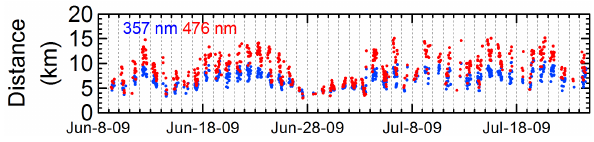
Fig. 17. Horizontal distances ( D ) of air masses measured by MAX-DOAS for the 0-1 km layer. D values at 357 and 476 nm are shown in blue and red, respectively.